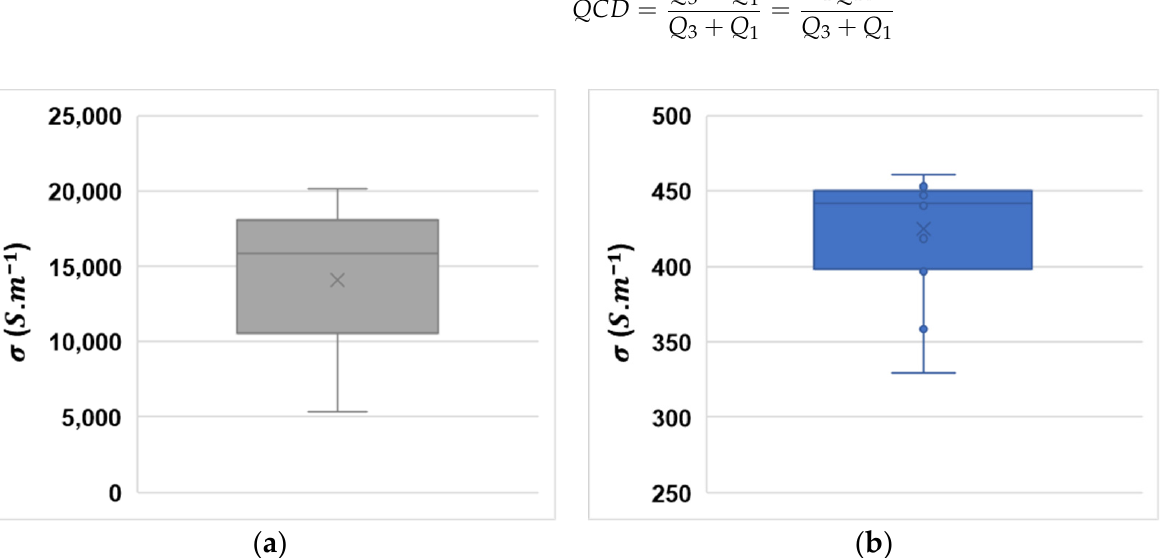
Figure 15. Whisker-box graphs computed from 17 samples coated with ( a ) copper or ( b ) carbon composites.